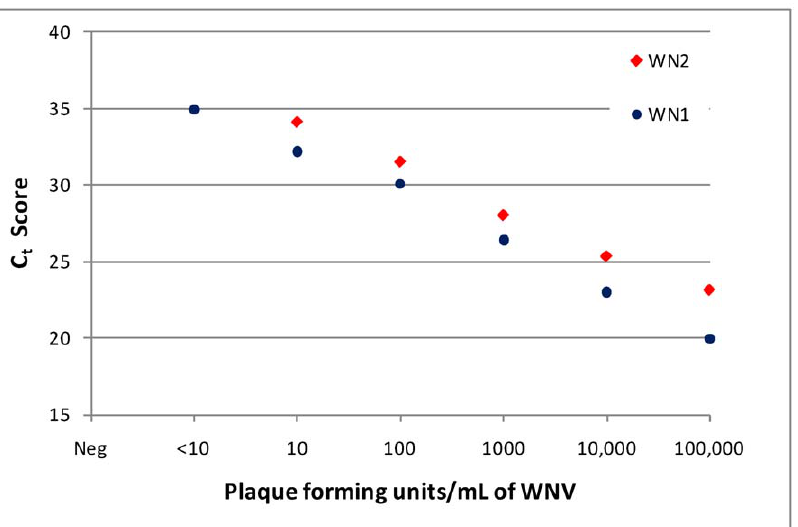
Figure 3. Relationship between threshold cycle (C t ) score and West Nile virus (WNV) titer. Known titers of WNV (CA04 isolate) grown in Vero cell culture were analyzed with an Applied Biosystems 7900 Real-time PCR machine (see Methods section) utilizing WN1 and WN2 primer/probe sets, C t scores are shown. (508 and 513) alternated positive/negative/positive. The five remaining birds were RNA-positive on only one occasion.